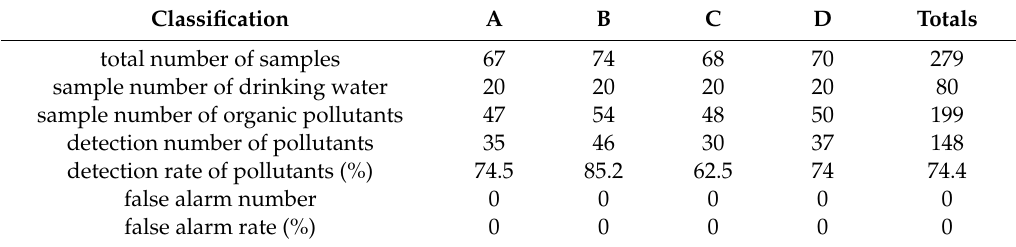
Table 7. Qualitative discrimination results without the improved algorithm.